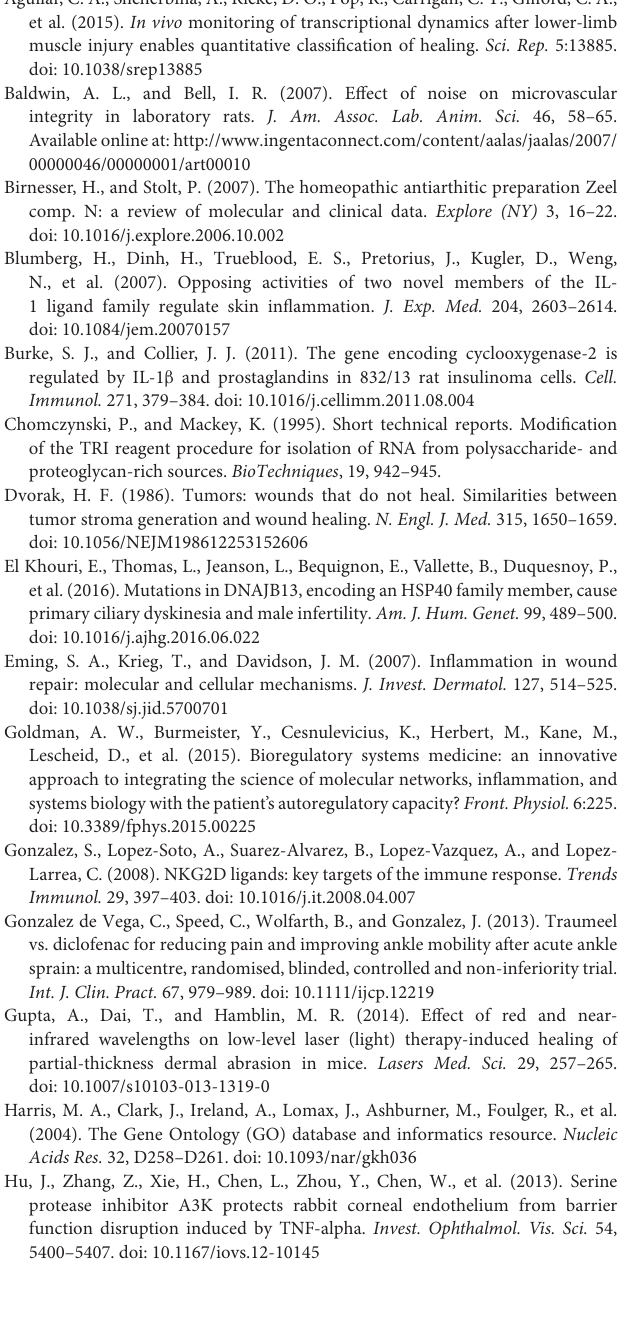
sample and each UCSC ID. The log 2 fold change and P -value by EdgeR are also shown for each transcript. Supplementary Table 4 | Gene ontology (GO) categories for differentially expressed genes affected by Tr14 treatment of wounds over time. RNA-seq data was analyzed to identify transcripts modulated by Tr14-IO during wound repair, as shown in Supplementary Table 3 . The transcripts were then organized using DAVID (Huang da et al., 2009) into Gene Ontologies that covered those transcripts at each time point post-injury.